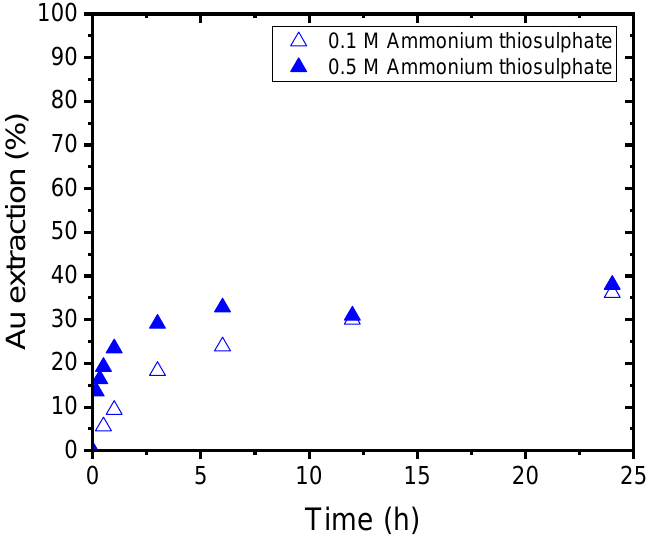
Figure 14. Effect of varying thiosulphate concentrations on gold extraction for Sample 2 at 0.5 M